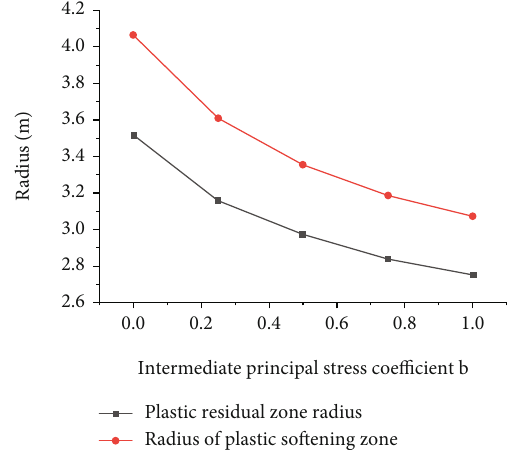
Figure 10: Radius of the plastic zone corresponding to di ff erent b